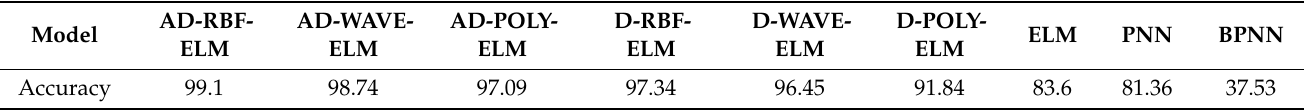
Table 5. Bearing status information (University of Cincinnati). Fault